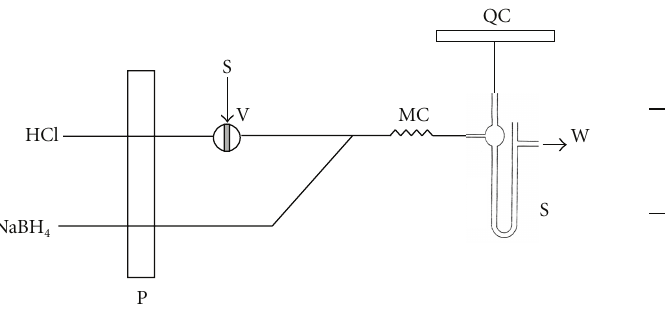
Figure 2: Multicommutated flow system. On the left the time sequence. S: sample (7.2 mLmin − 1 ), MC: mixing coil (50cm), PS: phase separator, QC: quartz cell, W: waste, and P: peristaltic pump. V1, V2: solenoid valves. HCl: 5% (v/v): 3.2 mLmin − 1 ; NaBH 4 : 0.5% (w/v) solution in 0.05% (w/v): 1.7mLmin − 1 . N 2 : carrier gas (nitrogen), 0.32 Lminmin − 1